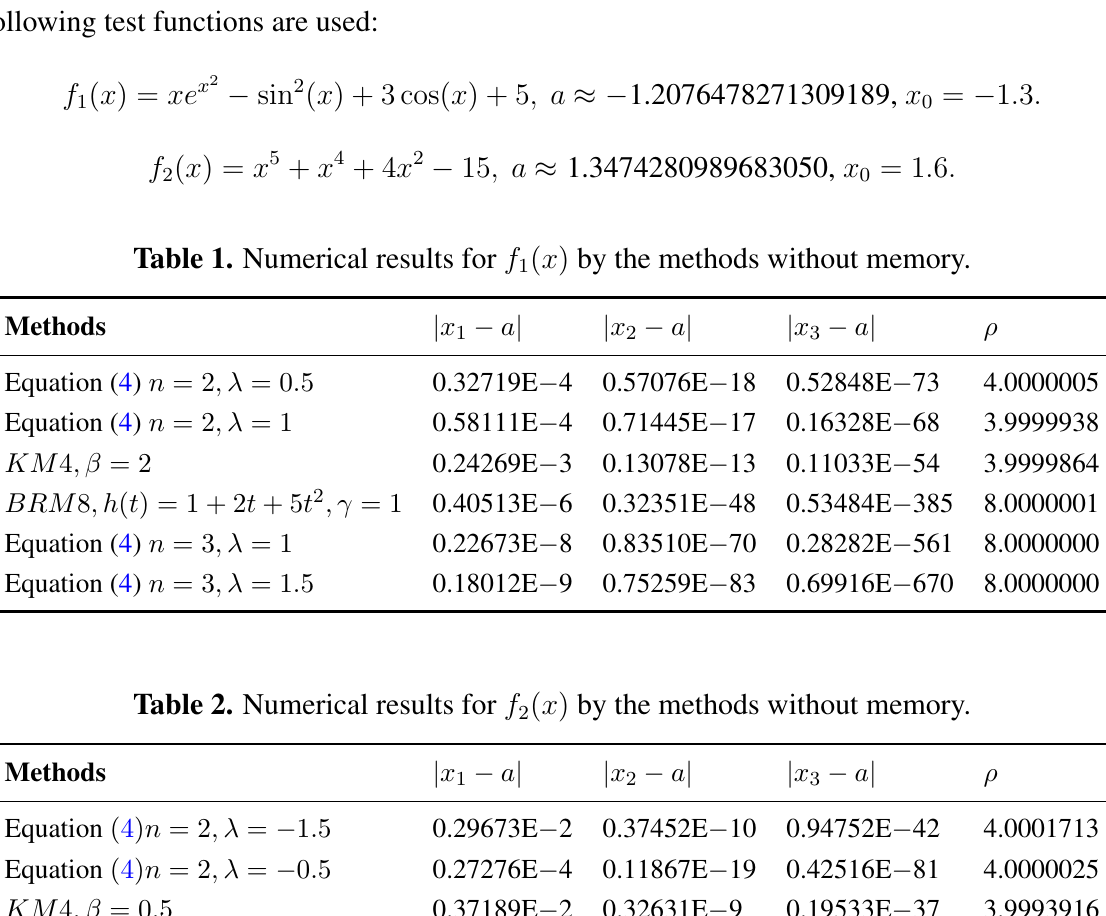
Table 2. Numerical results for f